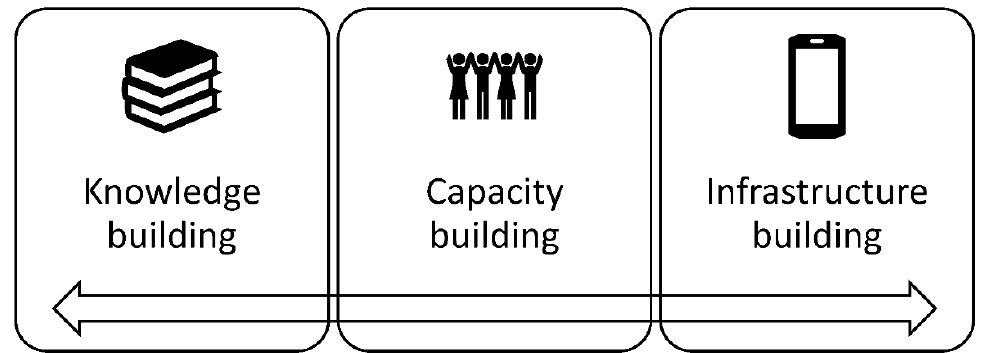
Figure 2. The three pillars of good practice.